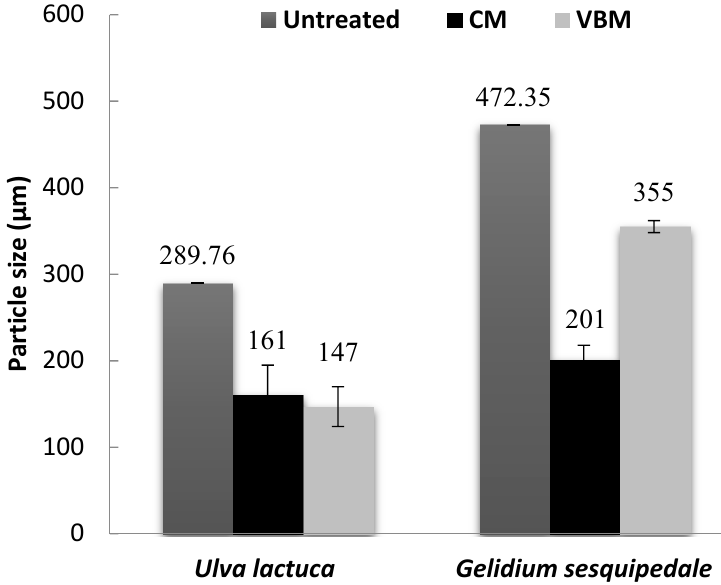
Figure 2. Mean particle sizes of untreated and milled algae biomass. Values correspond to mean ± SD (standard deviation) of measurement performed in duplicate.